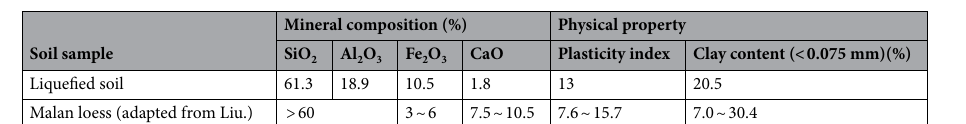
Table 2. Mineral composition and physical property of liquefied soil and Malan loess.